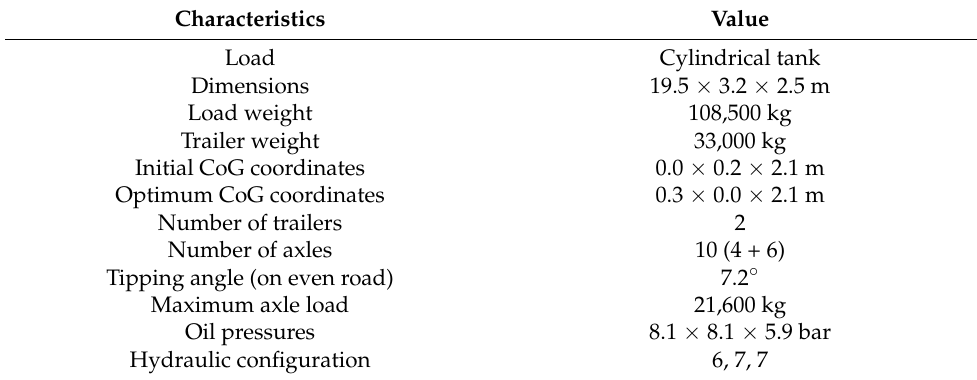
Table 5. Key values of the optimized